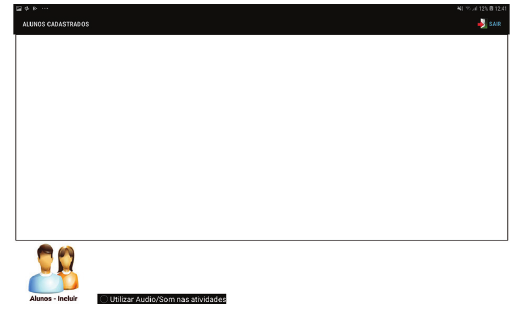
Figure 5: Student data.